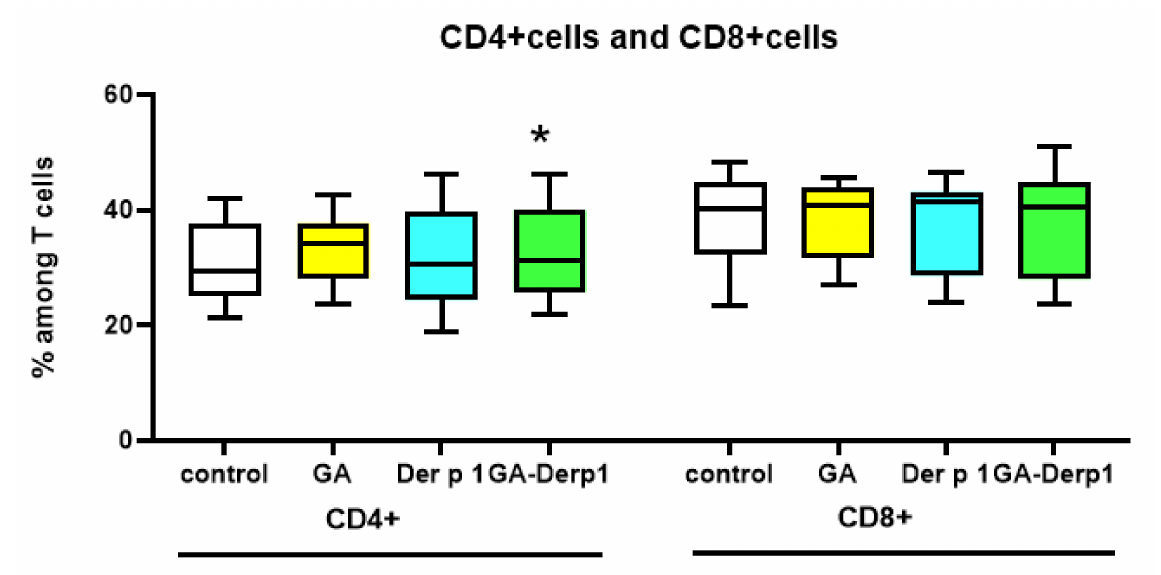
Figure 4. T cell subsets after cultivation with GA–Der p 1 mixture. Data are presented as box-and- whisker plots, with boxes extending from the 25th to the 75th percentile, with a horizontal line at the median, while the whiskers extend to the lowest and highest data points (n = 10). * Indicates a significant difference ( p < 0.05) vs.